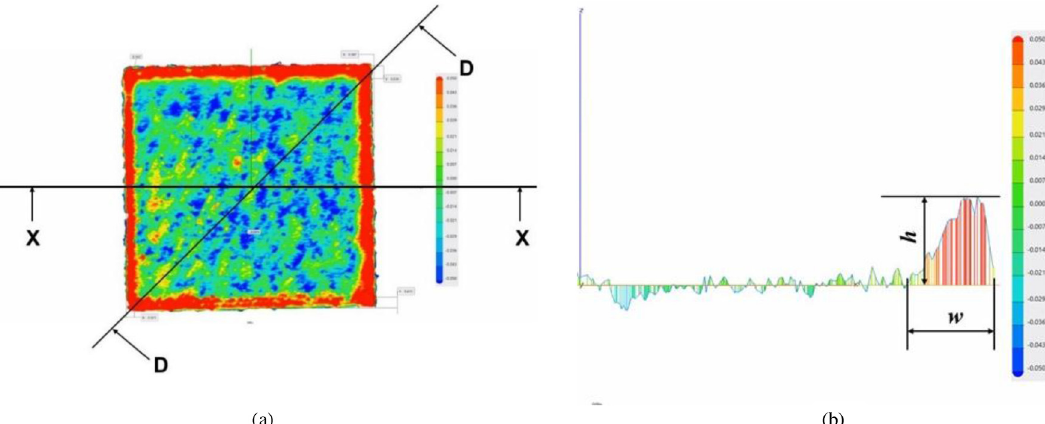
Fig. 4. Sections used for the assessment of edge and corner effect (a) by measurement of edge and corner height and width (b).